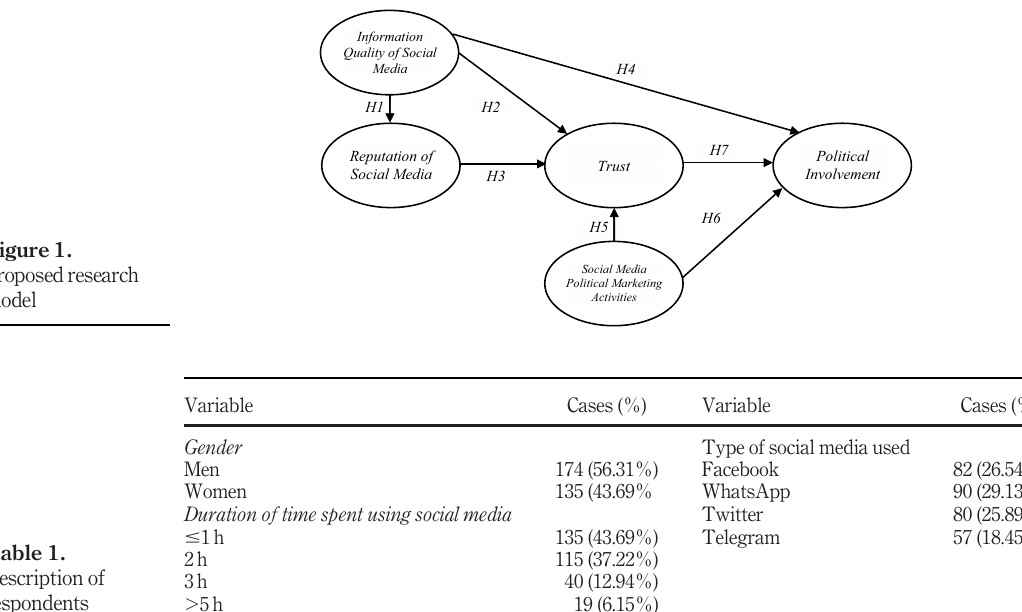
Table 1. Description